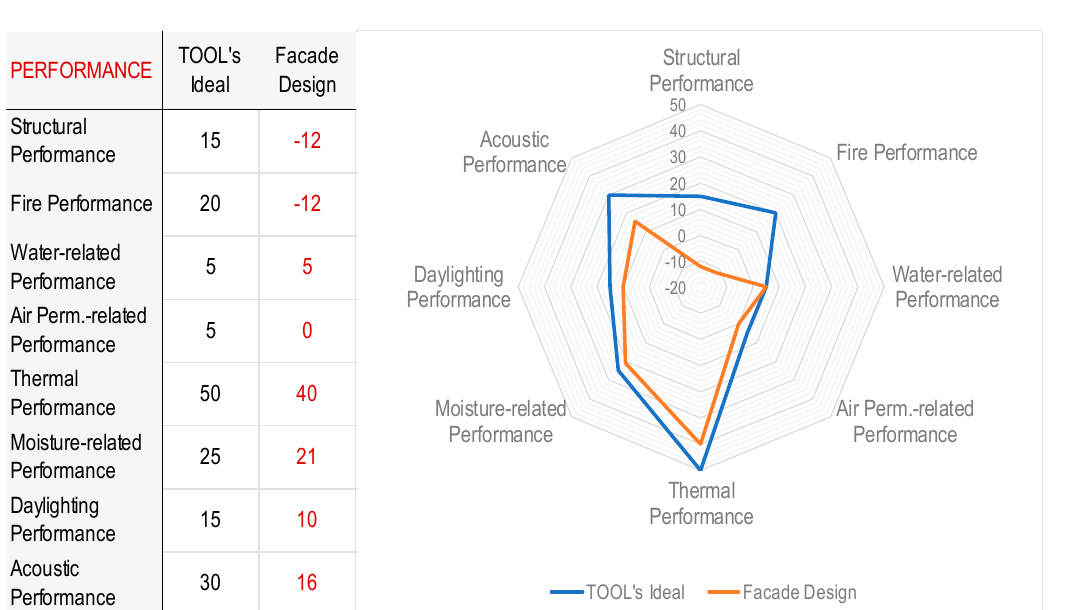
Figure 5. Overall facade performance evaluation (representative screenshot).